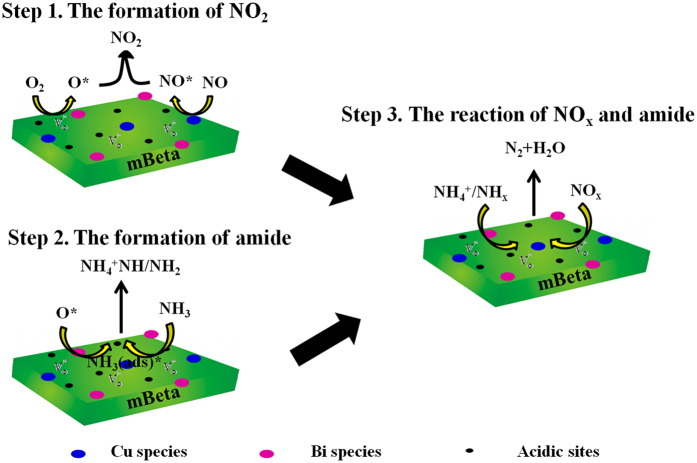
A possible reaction mechanism of NH3-SCR of NO on Cu1Bi1-mBeta catalyst.